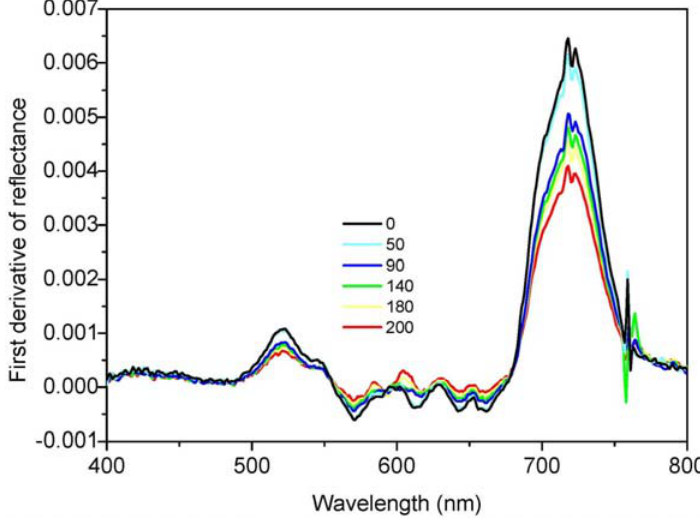
Figure 4. First derivative reflectance spectra across the visible and Near Infrared (NIR) region for the juniper canopy with varying cone density